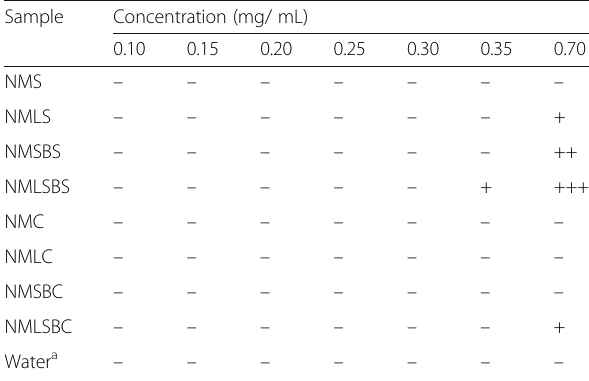
Table 9 Cytotoxic effect of neem cosmetics on human blood RBC Sample